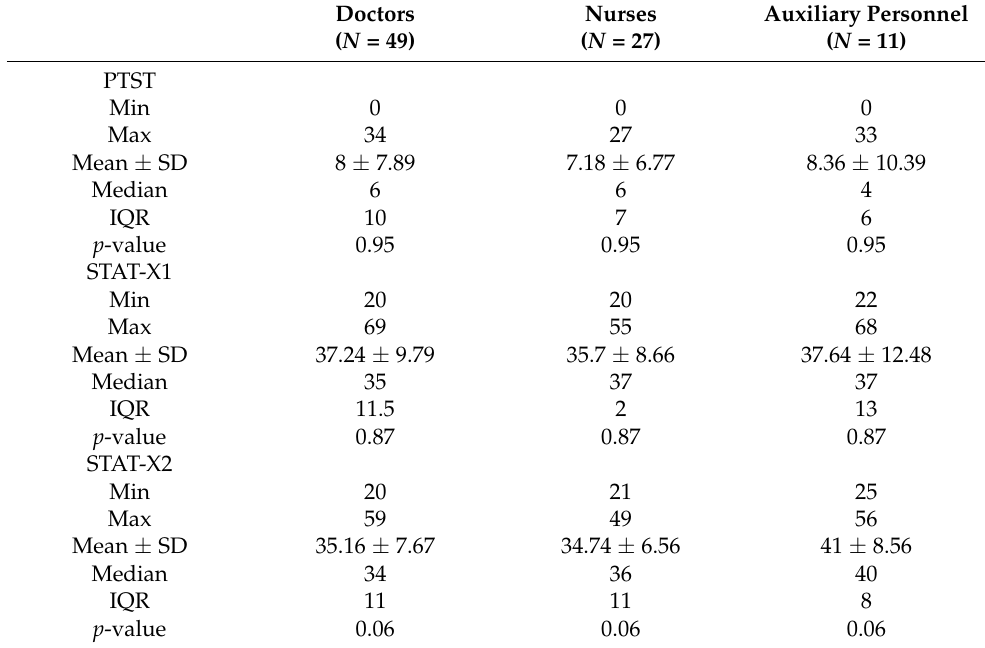
Table 2. Descriptive statistics of the psychological tests. TPST—Post-Traumatic Stress Test; STAI-X1— State-Trait Anxiety Inventory—state; STAI-X2—State-Trait Anxiety Inventory—trait; Min—Minimum; Max—Maximum; SD—Standard Deviation; IQR—Inter Quartile Range.